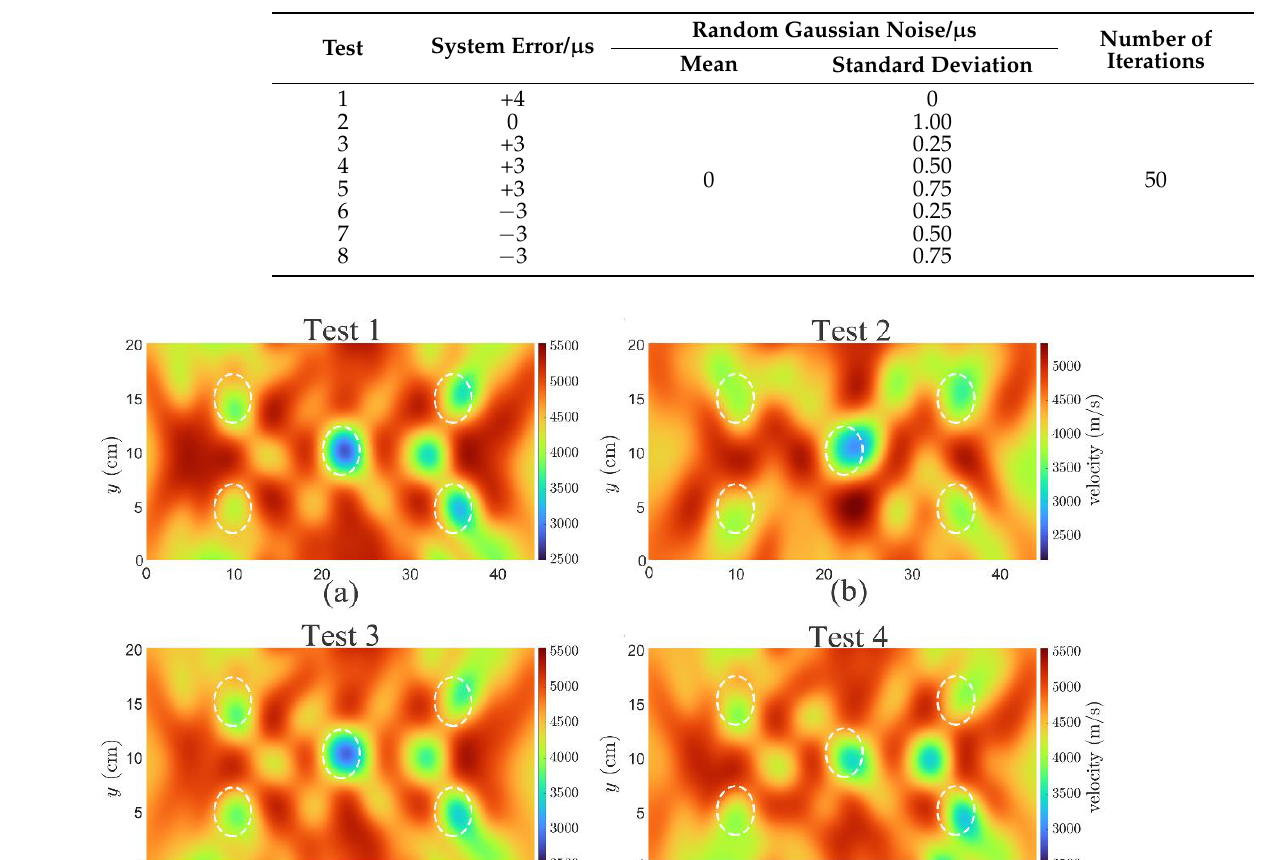
Table 2. Setup of 8 robustness tests.